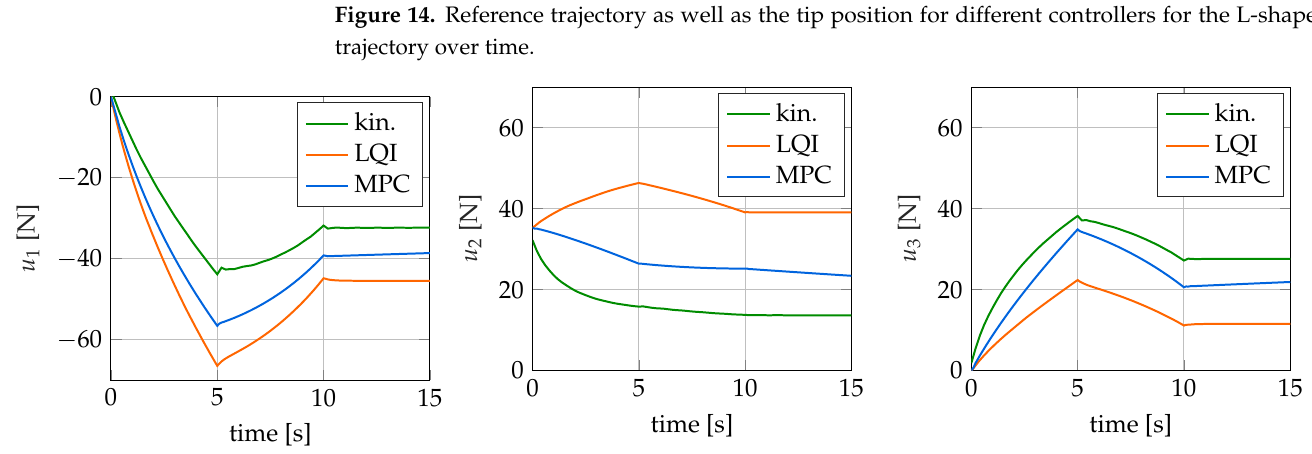
Figure 15. Actuation forces for the L-shape trajectory over